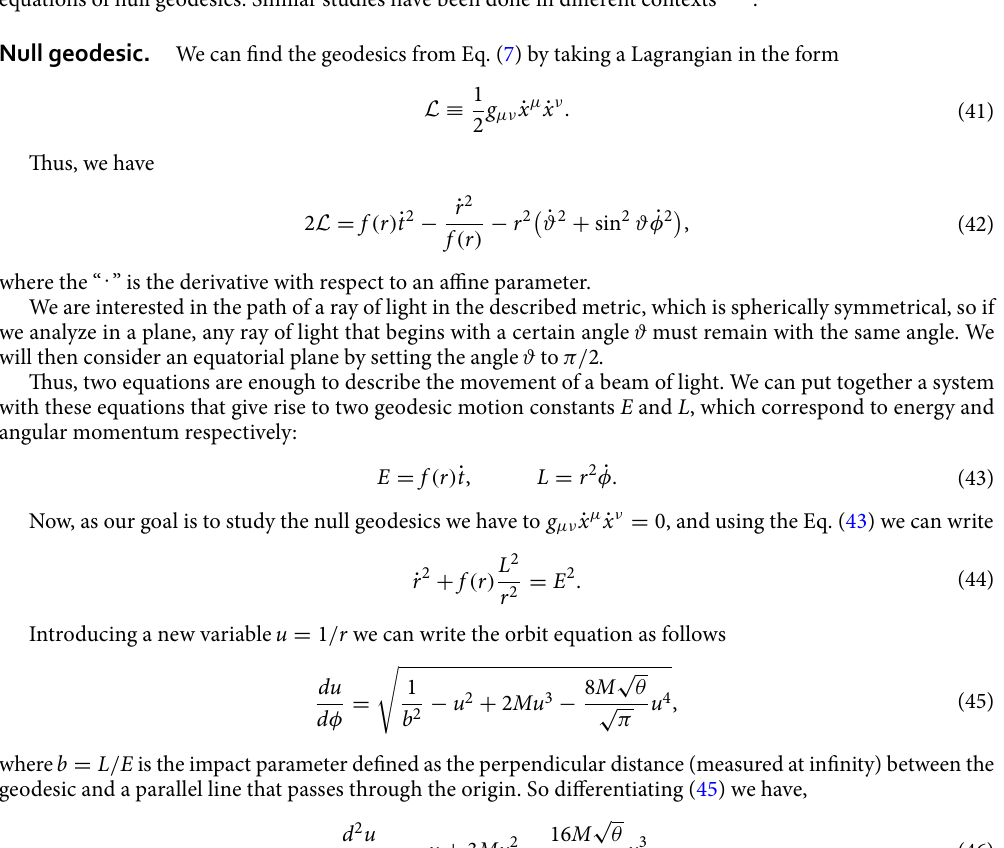
Figure 4. Complex plane of the QNMs. In plot ( a ) we have the results obtained by the WKB approximation, while in ( b ) we use continuous fraction. The markers denote the multipole number as: l 3 (diamond), while the colors denote the value of the noncommutative parameter (cid:31) (square) and l = 0.05 (red), (cid:31) 0.10 (blue) and (cid:31) 0.12 (black), (cid:31) = = =